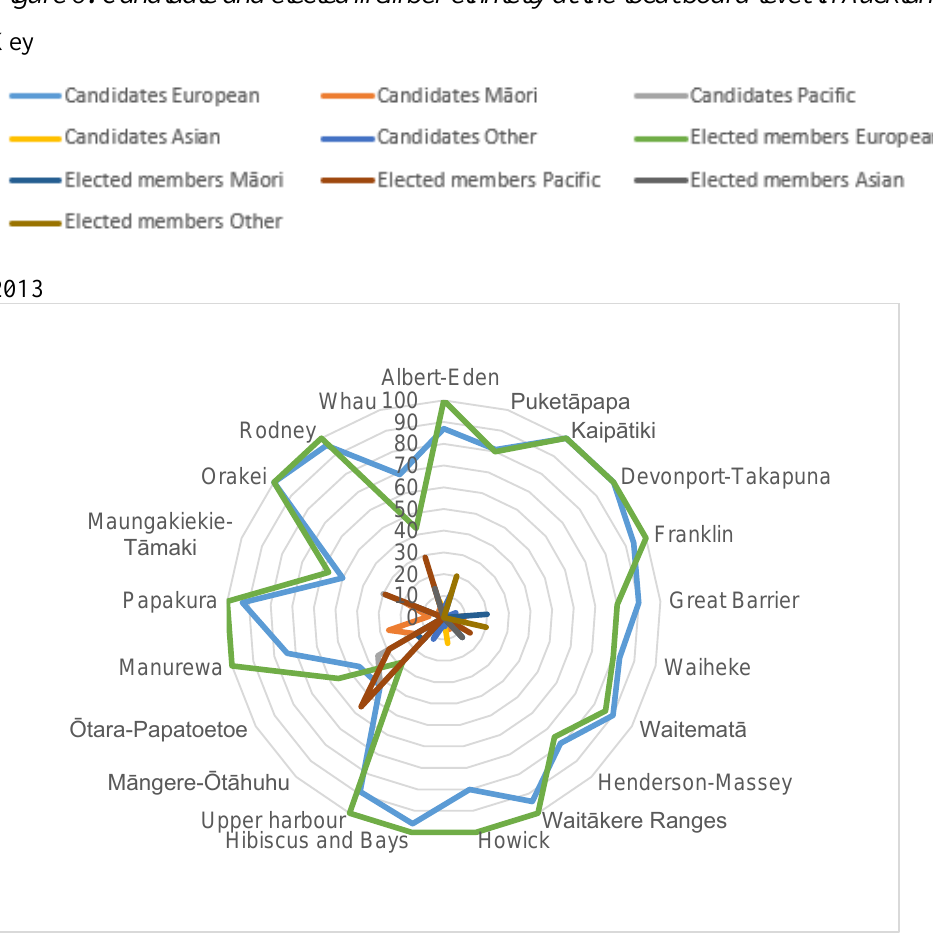
Figure 6: Candidate and elected member ethnicity at the local board level in Auckland, 2013 to 2019 Key